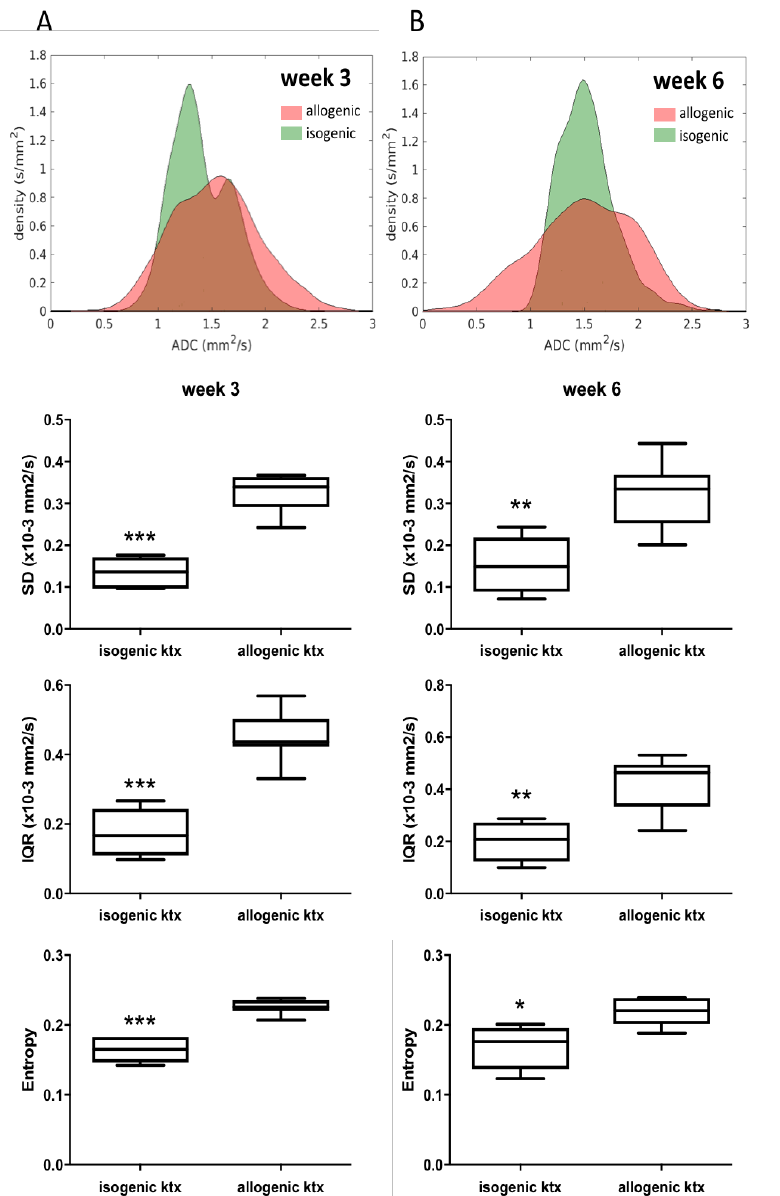
Figure 4. Assessment of tissue heterogeneity by histogram analysis of ADC maps. Cumulative histograms in allografts and isografts at week 3 ( A , left column) and 6 ( B , right column) after ktx show increased tissue heterogeneity after allogenic ktx. Box plots show parameters of heterogeneity (SD, IQR and entropy) derived from the quantitative histogram. Each box stretches from the 25th percentile at lower edge to the 75th percentile at upper edge; the median is shown as a line across. Significant differences are indicated with * p < 0.05, ** p < 0.01 and *** p <